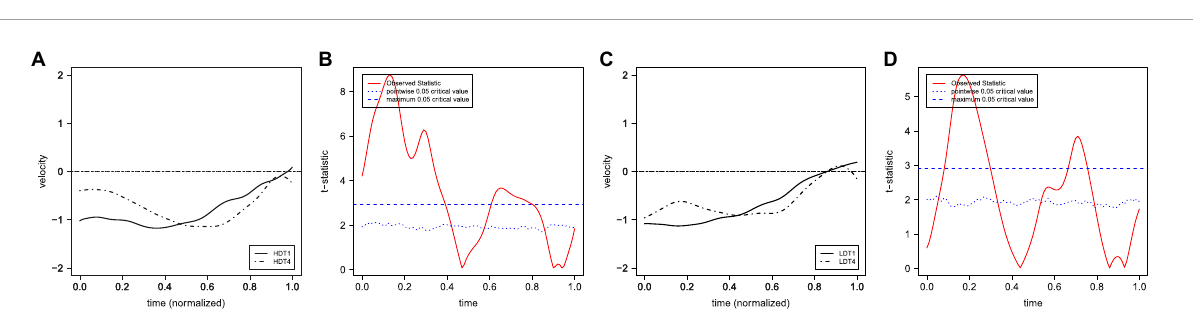
FIGURE5 The average of the (normalized) F0 velocity profiles for T1 and T4 in the HD and LD lexical conditions produced by young participants [ (A) HD; (C) LD] and their functional t -test statistic [ (B) HD; (D) LD]. The solid lines represent the F0 curves of T1, and the dot-dash lines represent the F0 curves of